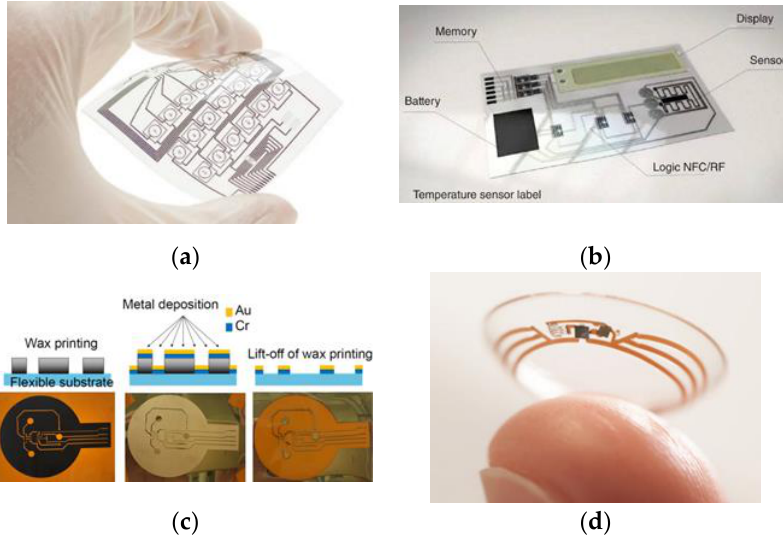
Figure 4. ( a ) Printed flexible circuit board [22] ( b ) Printed temperature sensor using inkjet printer [21] ( c ) Subtractive printing [23] ( d ) Intelligent contact lens using inkjet printing [25].